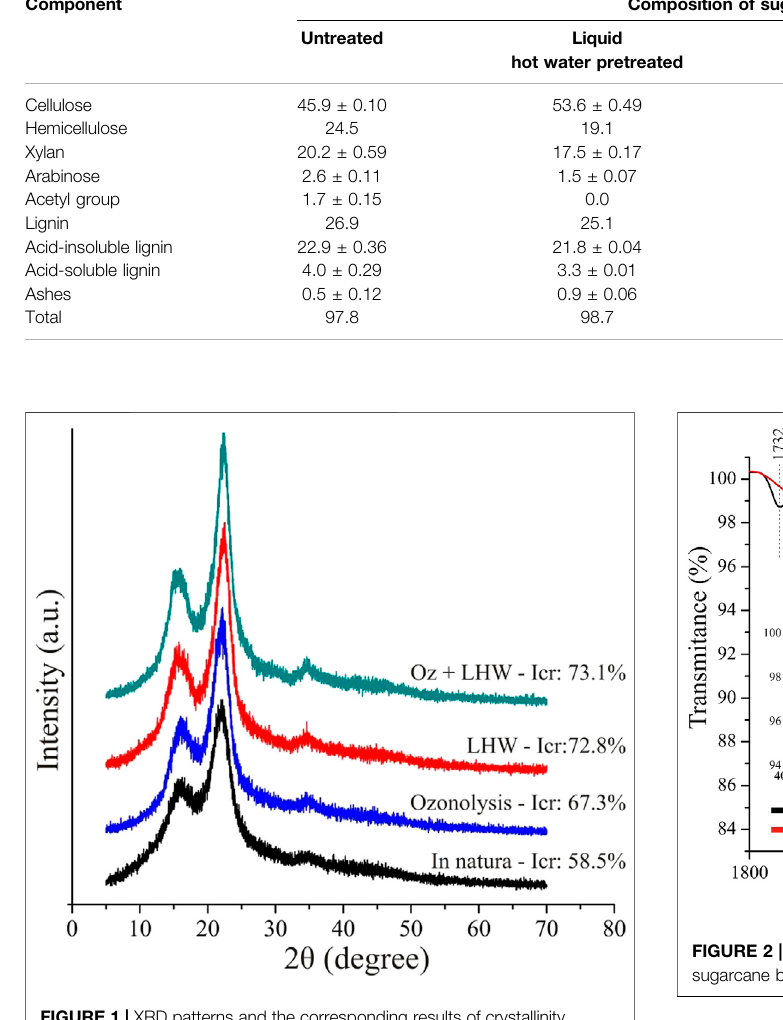
FIGURE 1 | XRD patterns and the corresponding results of crystallinity index(Icr)forinnaturesugarcanebagasse,ozonolysis,LHW,andozonolysis+LHW pretreatments.